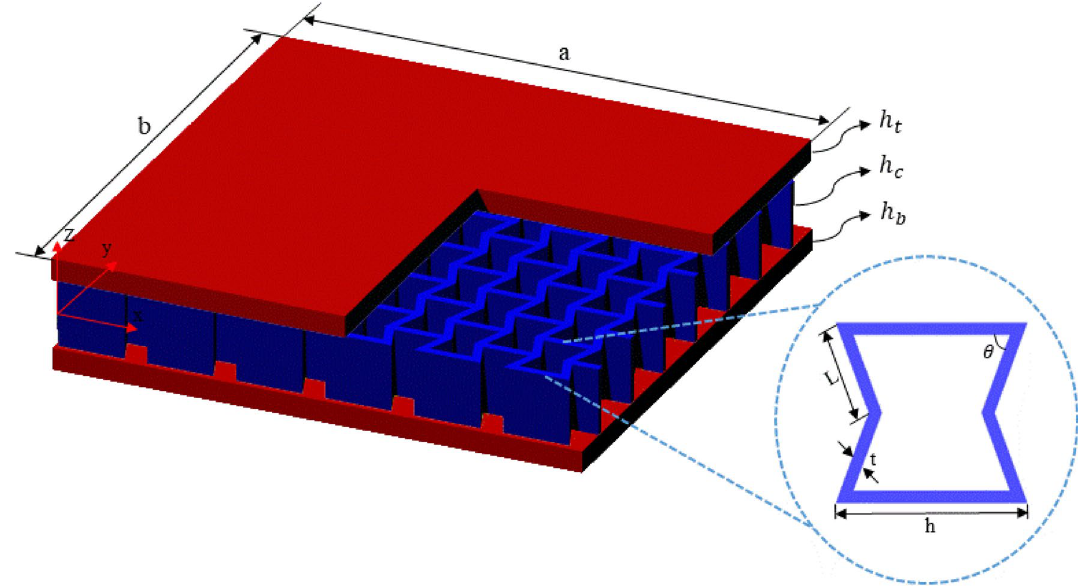
Figure 1. Three-layered sandwich plate with a re-entrant lattice structure as a